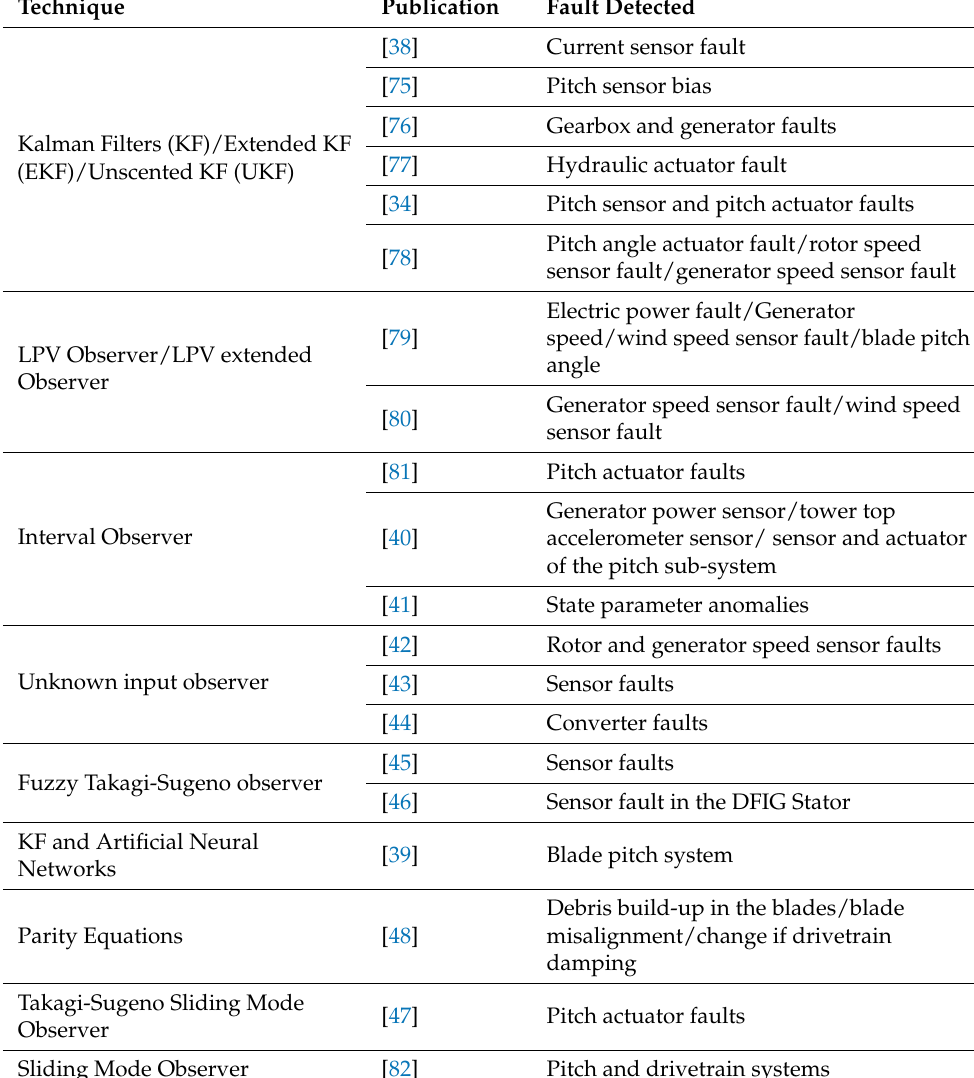
Table 2. List of some of the most relevant model-based FDD techniques.